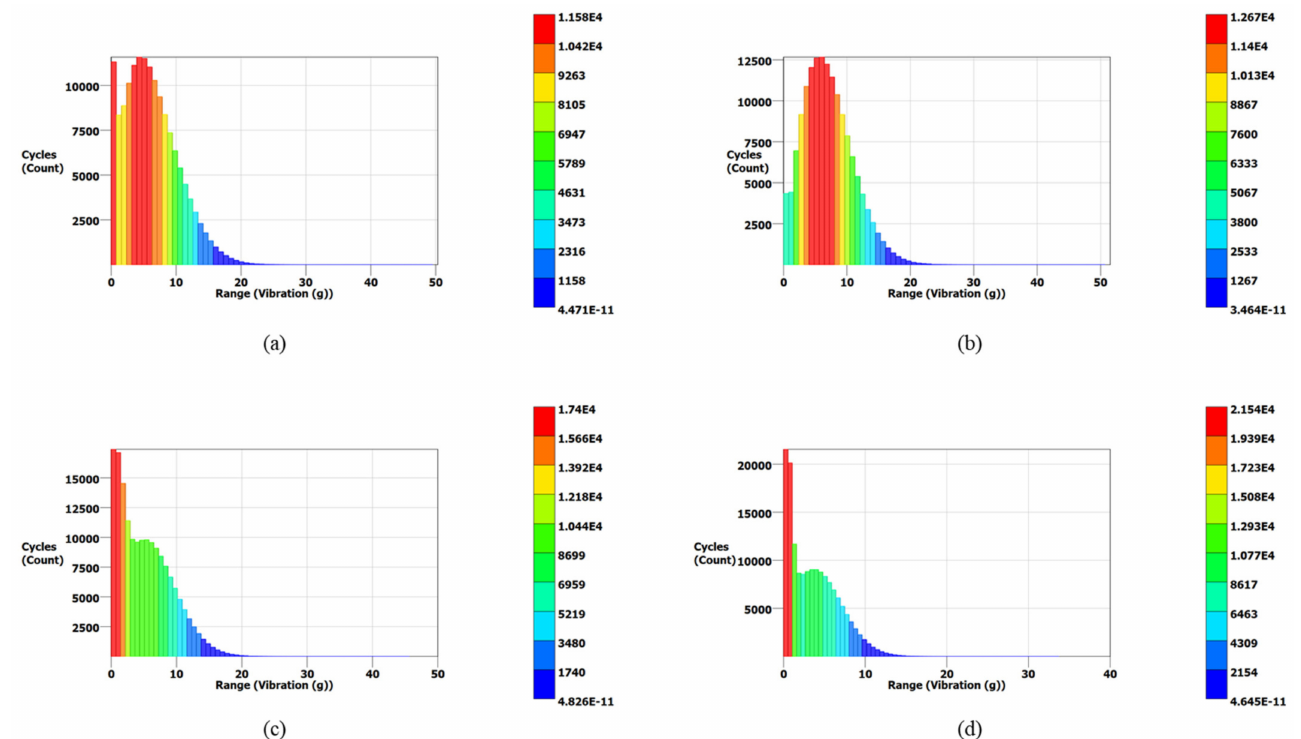
Figure 16. PDF results for turbine blades using the Dirlik approach: ( a ) the solid blade; ( b ) the